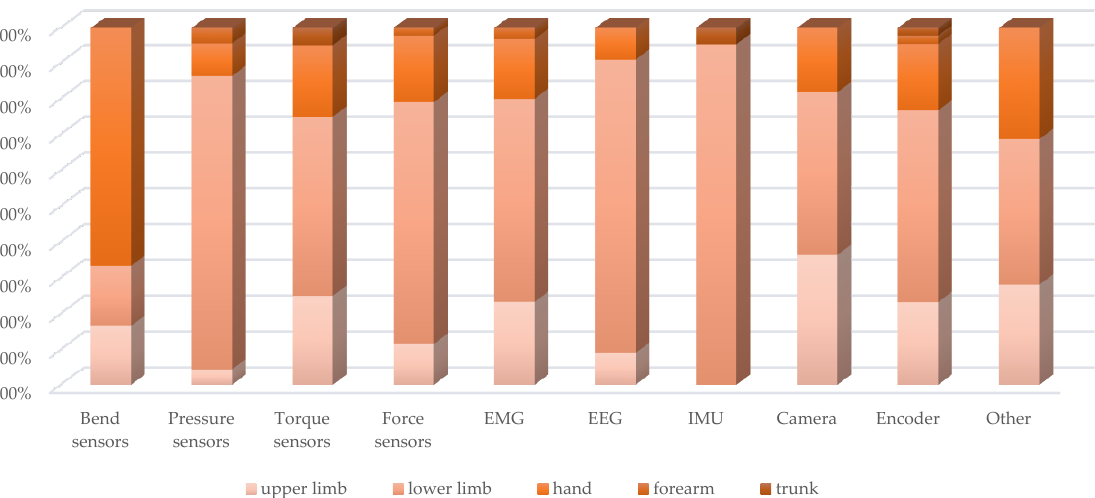
Figure 26. The distribution of the anatomical district to which the exoskeleton is devoted for the different sensor types. For almost all types of sensors, LLE is dominant, particularly for IMUs (95%), pressure sensors (82%) and EEG (82%). Bending sensors are mainly used in HED (67%). Bending sensors are somewhat used when soft-actuators and torque motors